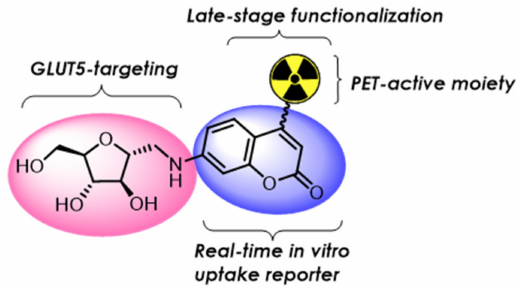
Figure 1. GLUT5-specific probe for delivering the fluoride for PET